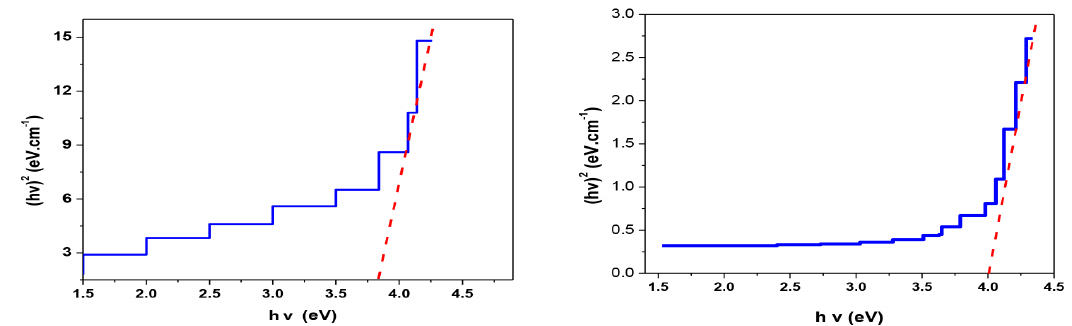
Fig . 8. The (αhν)2 as a function of hν spectra of (right): A sample and (left): A sample